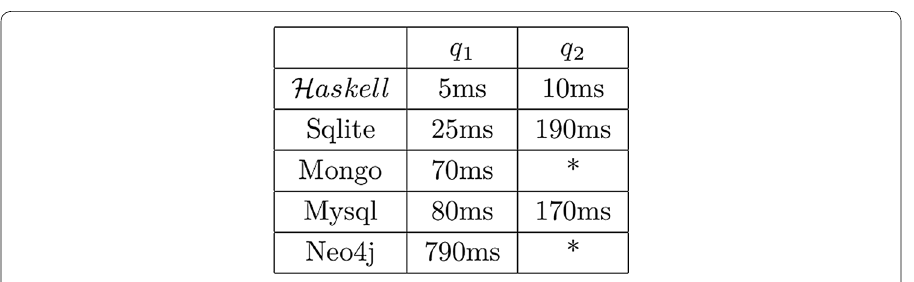
Fig. 9 Performances comparison